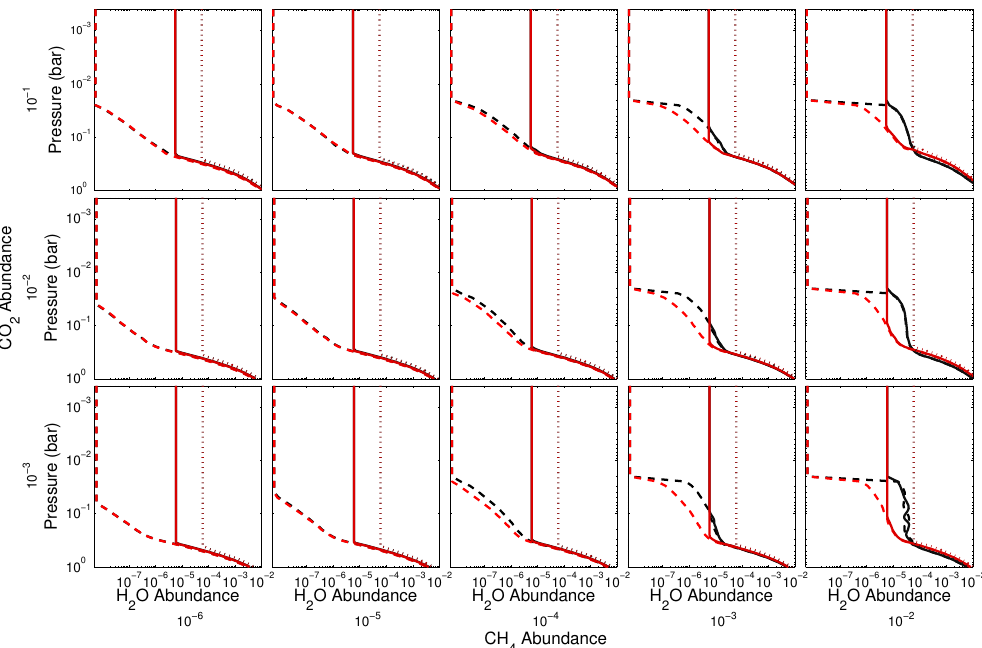
Figure 5. Atmospheric H 2 O Profiles. Equilibrium H 2 O abundances as a function of CO 2 and CH 4 abundances. Line types and colours are as in Fig.